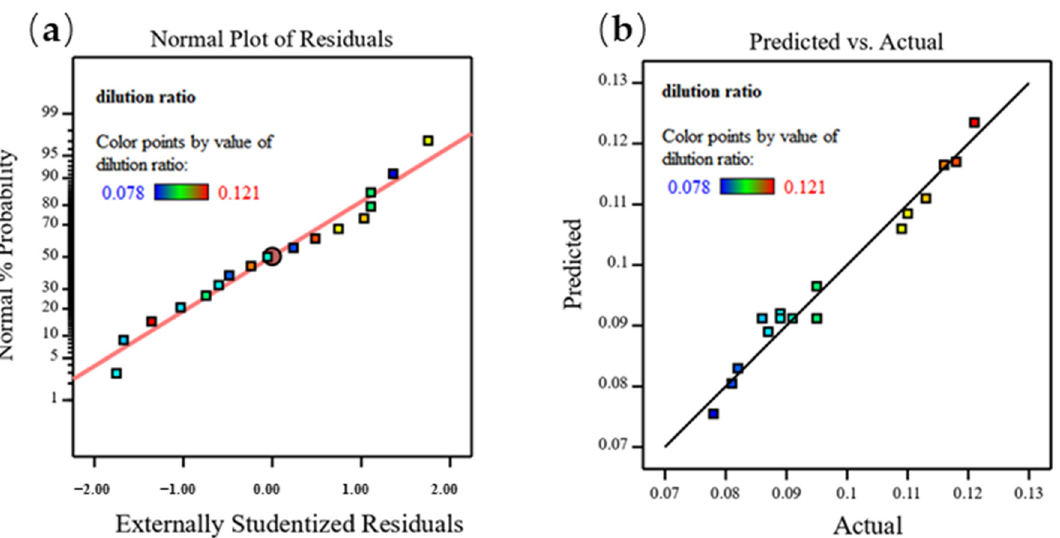
Figure 6. ( a ) Residual distribution of the dilution ratio. ( b ) Relationship between the predicted and actual values of the dilution ratio.